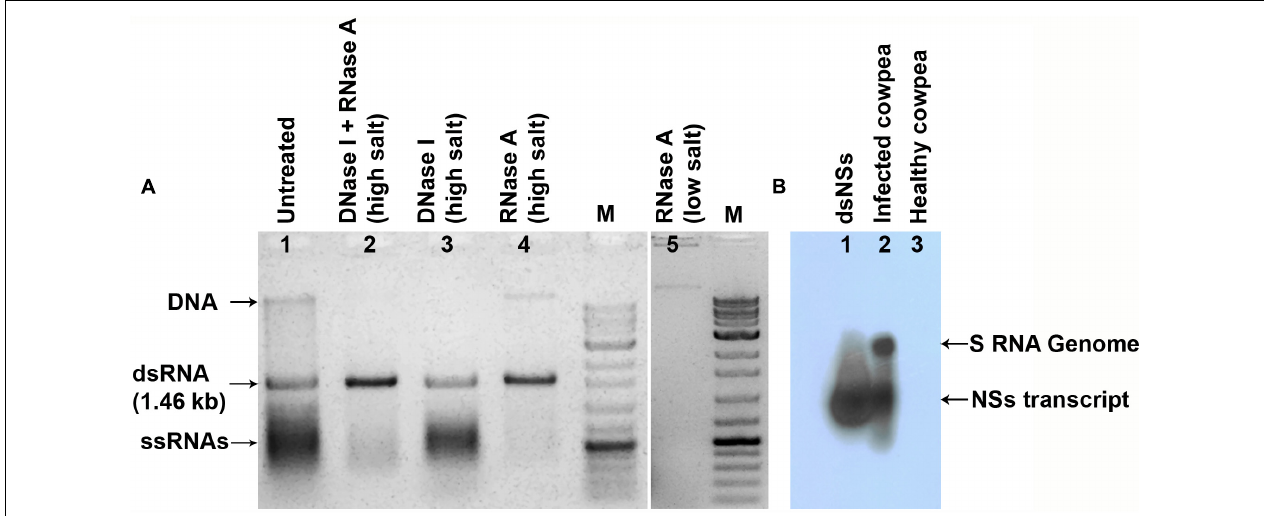
FIGURE 1 | The dsRNA specific to NSs gene of groundnut bud necrosis virus (GBNV) expressed in E. coli strain HT119. (A) Agarose gel showing nuclease digestion of the isolated nucleic acid from the bacteria transformed with pL4440, containing NSs. RNase A in high salt resisted digestion of 1.46 kb fragment (lane 4), but completely digested (lane 5) in low salt condition, indicating double stranded form. (B) Northern blot sowing hybridization of dsNSs isolated from bacteria (lane 1) and GBNV infected cowpea plant (lane 2) with the DIG-labeled probe to the PCR product of NSs gene of